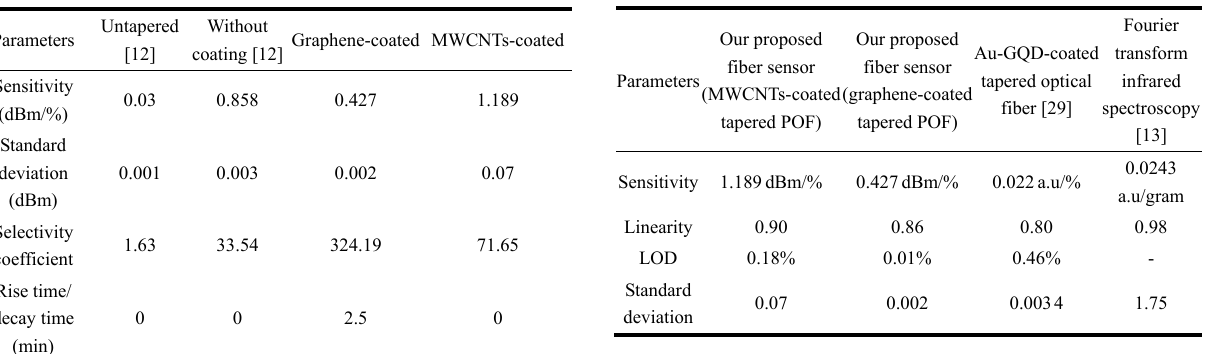
Table 3 Performance comparison with existing lard detection